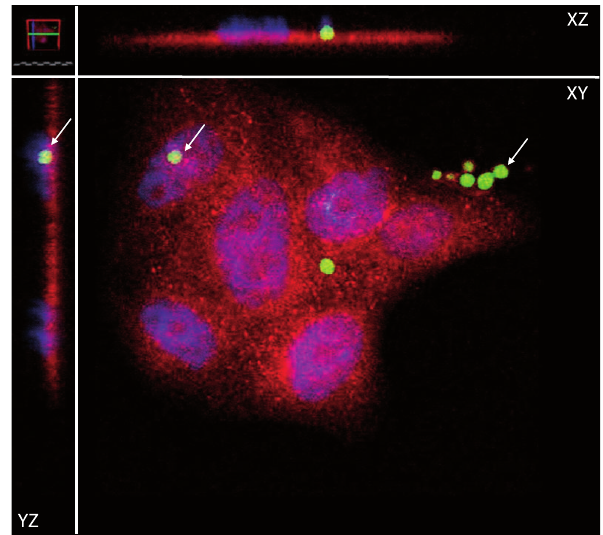
Figure 1. Localization of A.fumigatus conidia within the airway epithelial cell monolayer. GFP-expressing A. fumigatus conidia and primary AECs were co-incubated for 6 hours and treated with DAPI and monoclonal E-cadherin Alexa 594 antibody before visualization by confocal microscopy. Labeling of nuclei (blue) and the membrane tight junctional protein E-cadherin (red) allowed visualization of AECs. Some GFP-expressing A. fumigatus conidia (green) are found outside the cells, while others localize within the cell monolayer, in close association with AEC nuclei.